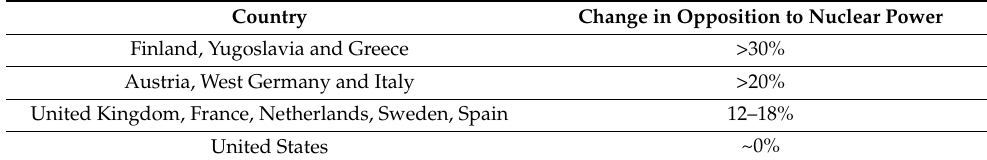
Table 7. Changes in opposition to nuclear power in select countries